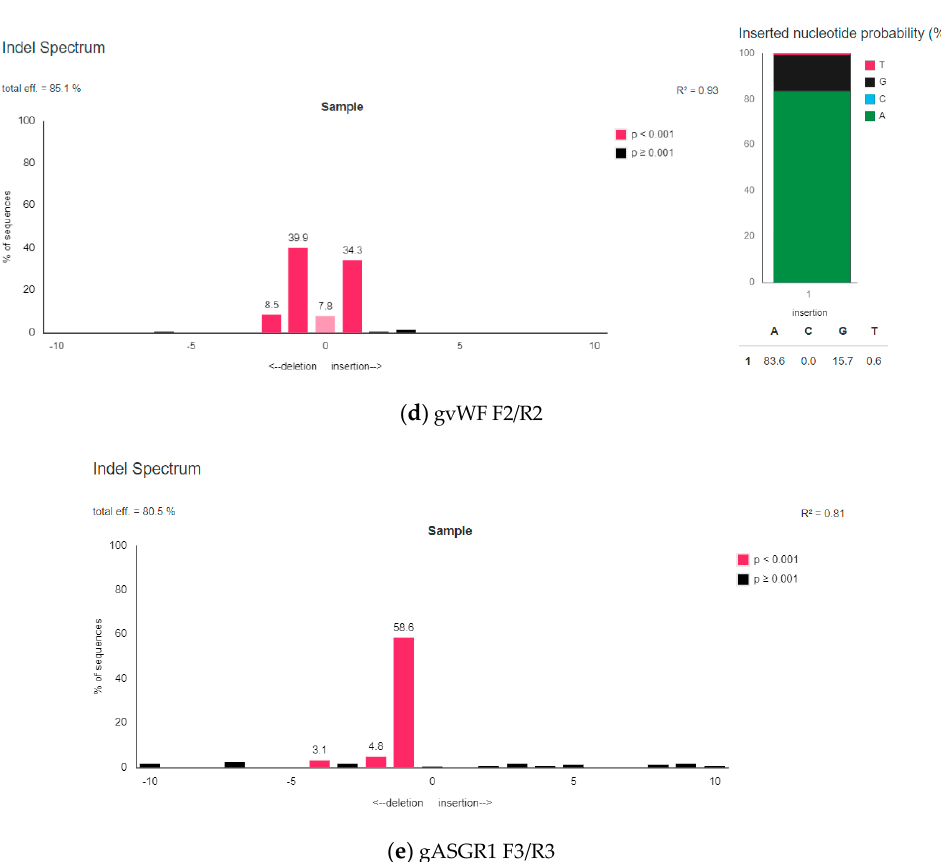
Figure 2. The indel spectrum and inserted nucleotide probability results for the CRISPR/Cas9 genetic constructs containing gRNA chosen as the best for disruption of tested porcine genes. Results obtained after use the plasmids with ( a ) gGGTA1 F1/R1; ( b ) gCMAH F3/R3; ( c ) g β 4GalNT2 F3/R3; ( d ) gvWF F2/R2; ( e ) gASGR1 F3/R3.